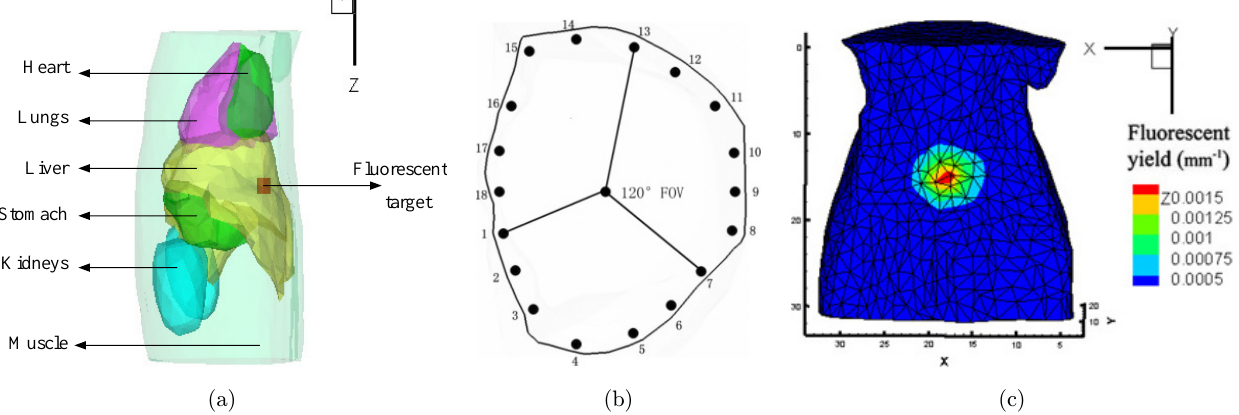
Fig. 2. (a) Torso of the mouse atlas model with a cylindrical °uorescent target in the liver. (b) The plane of excitation sources at z ¼ 16 : 4 mm and the black points represent the location of the isotropic point sources. (c) Mesh for generating synthetic measurements and photon distribution on